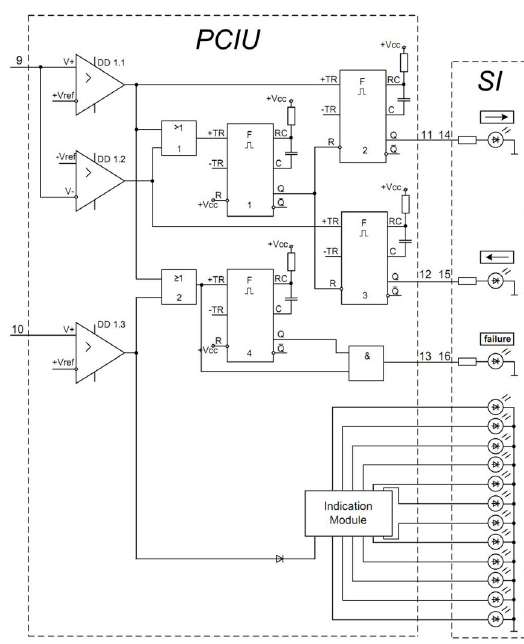
Figure 11. Filters Unit of Device.